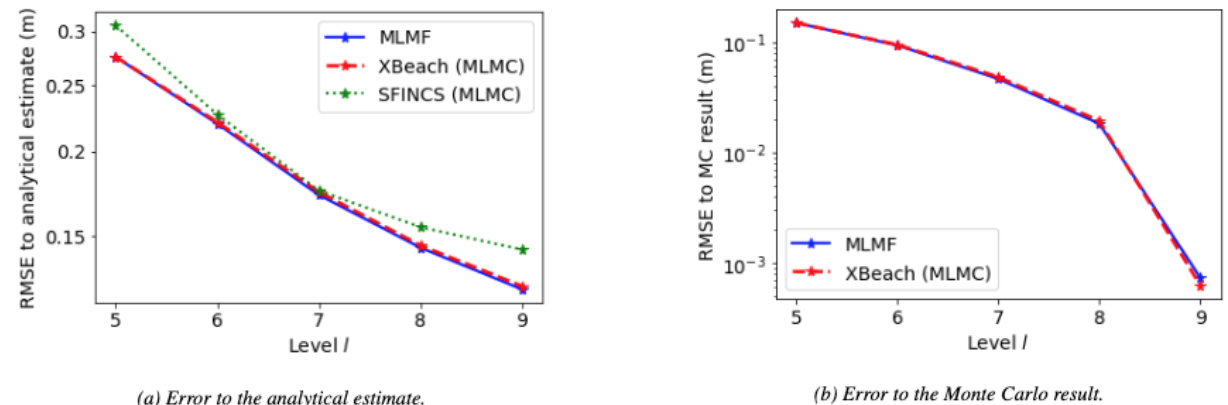
Figure 15. Error (RMSE) in the maximum run-up height as the resolution level becomes finer for the Carrier–Greenspan test case. The x axis indicates the finest level considered by the MLMC and MLMF estimator for that error and the errors from using MLMF and from using MLMC with a single model are both shown. A tolerance of (cid:15) = 1 × 10 − 3 is used in Eqs. (14) and (B7) for MLMF and MLMC respectively.